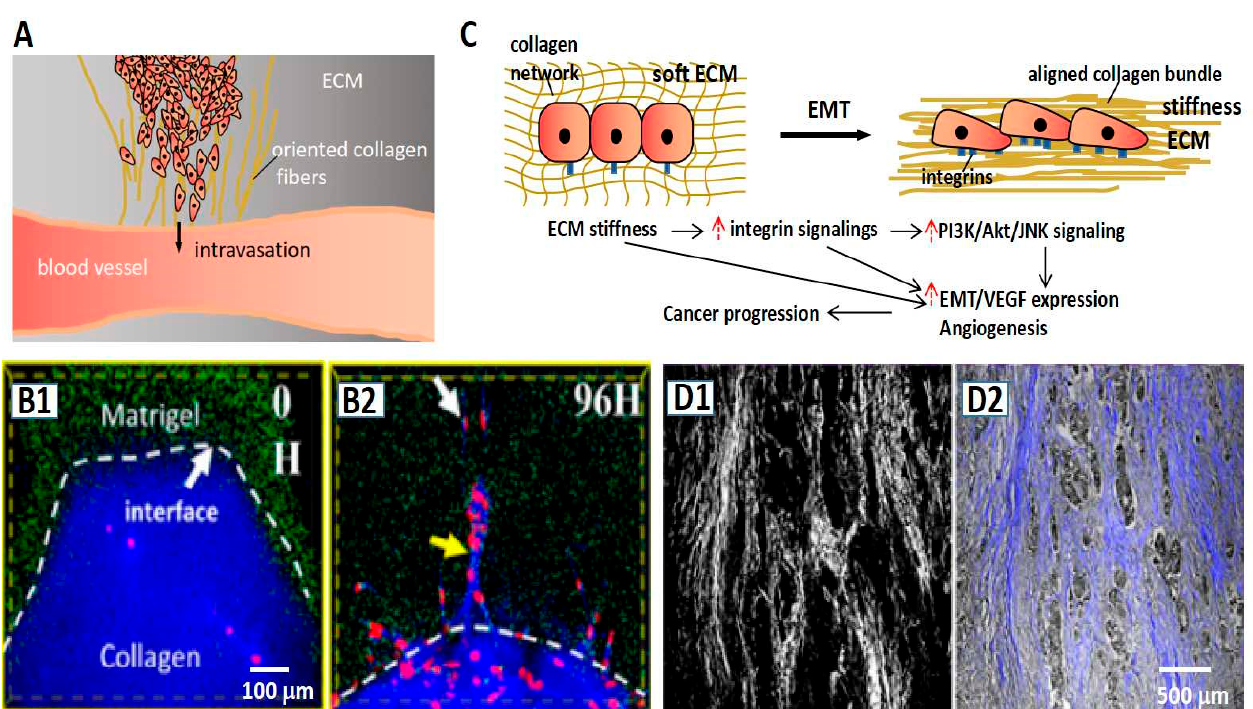
Figure 4. Collagens promote cancer invasion. ( A ) The schematic representation of oriented collagen fibers providing a “highway” to guide cancer cells in realizing the intravasation process. ( B1 , B2 ) The fluorescent images show the stiffness Matrigel (green) region is invaded by cancer cells (red) in the guidance of the oriented collagen fibers (blue) [59]. ( C ) The schematic representation of stiffness ECM inducing EMT accompanied with high adhesion of tumor cells. ( D1 , D2 ) Tumor cells (gray color in ( D2 )) invade along with the direction of collagen fibers. ( D1 ) The SHG signal of collagen fibers in the pathological section. ( D2 ) The merge of the light field and SHG signal of the pathological section [59].